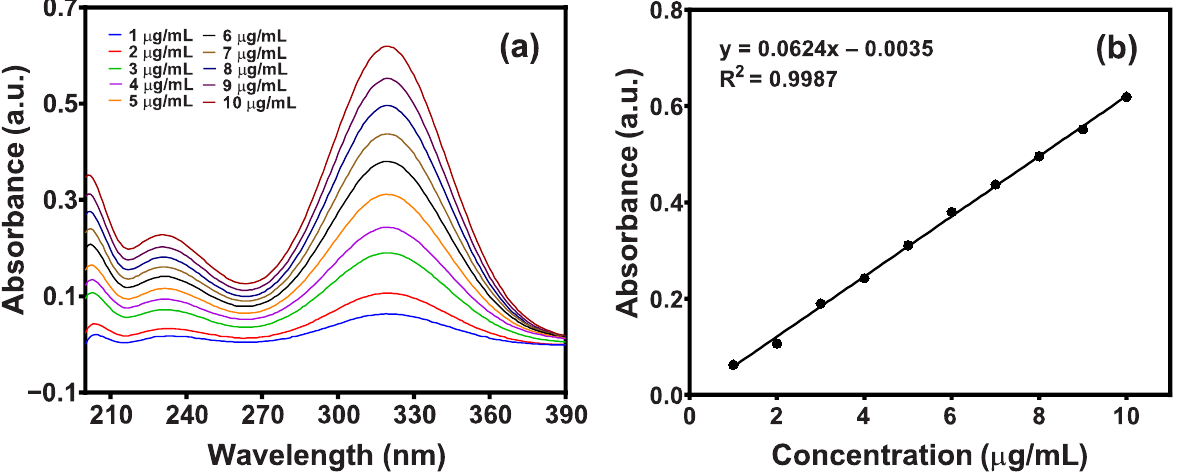
Figure 4. ( a ) Scanning curve and ( b ) calibration curve of standard metronidazole drug in a buffer solution of pH 7.4.